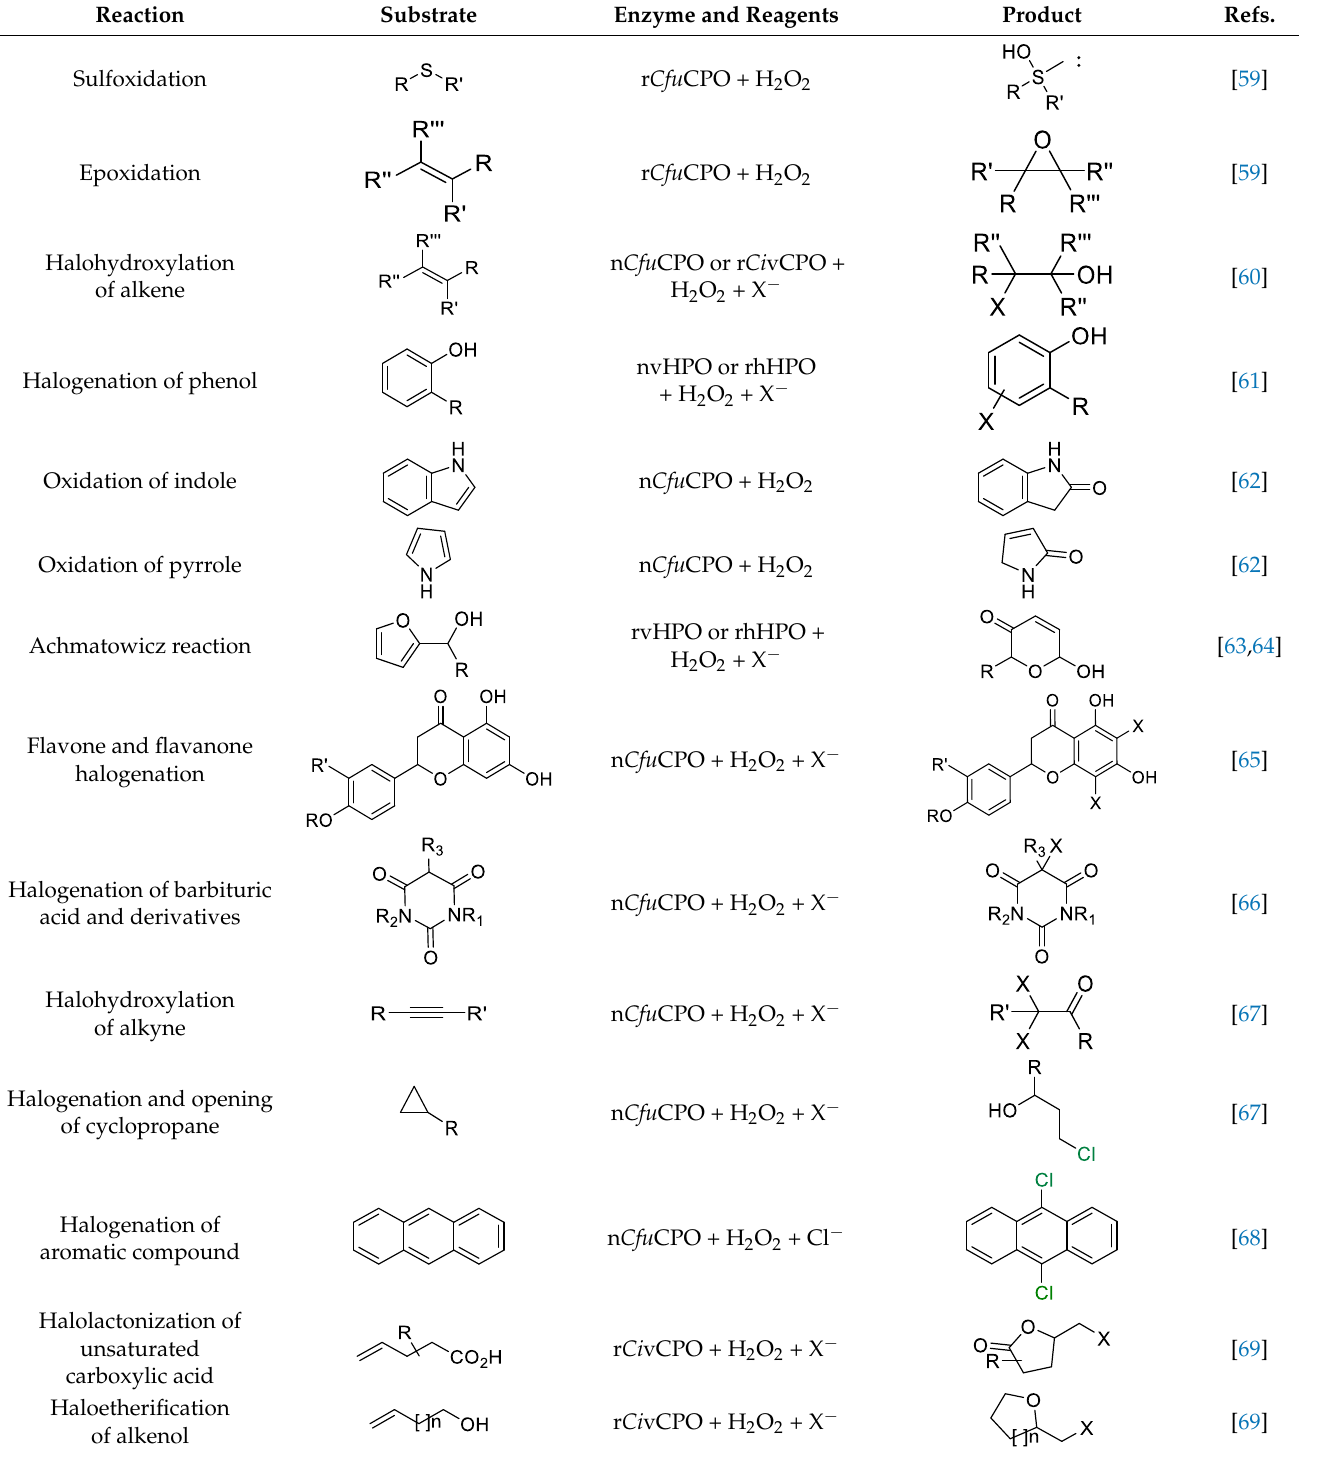
Table 2. Examples of biocatalytic reactions reported in the literature using haloperoxidases ( Cfu CPO: C. fumago heme-dependent chloroperoxidase, Ci vCPO: C. inaequalis vanadium-dependent chloroperoxidase, r: recombinant protein, n: native protein). Substrate Enzyme and Reagents Refs.